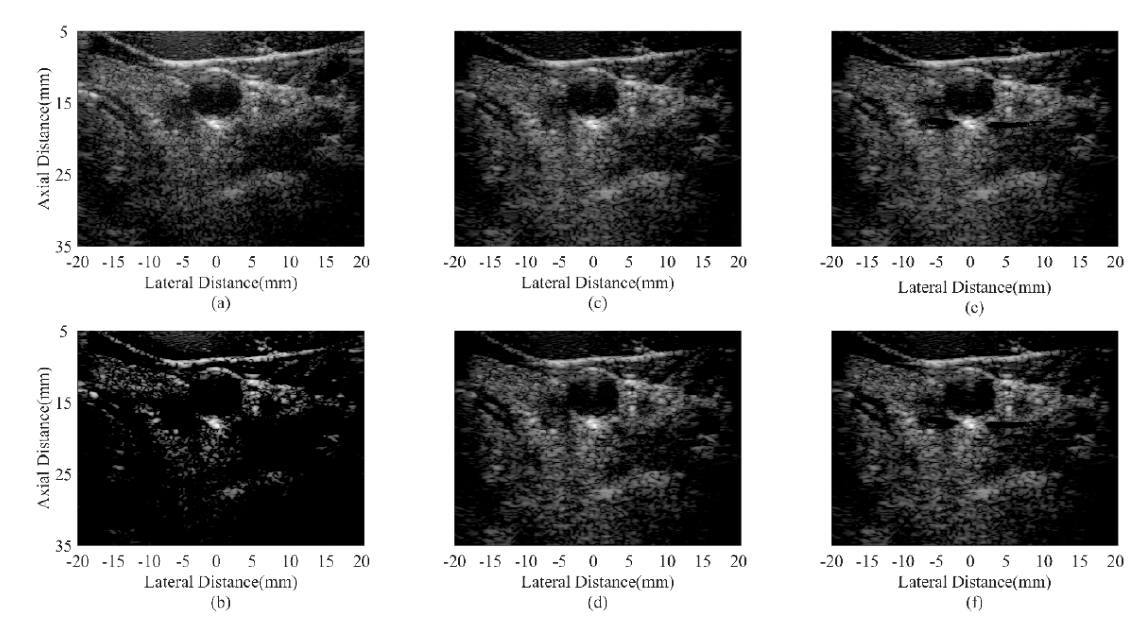
Figure 9. In vivo human carotid artery images using different beamformers: ( a ) DAS, ( b ) CF, ( c ) JTR-MV, ( d ) JTR-MV GCF, ( e ) JTR-ESBMV, ( f ) JTR-ESBMV GCF. All images are shown with a dynamic range of 60 dB.